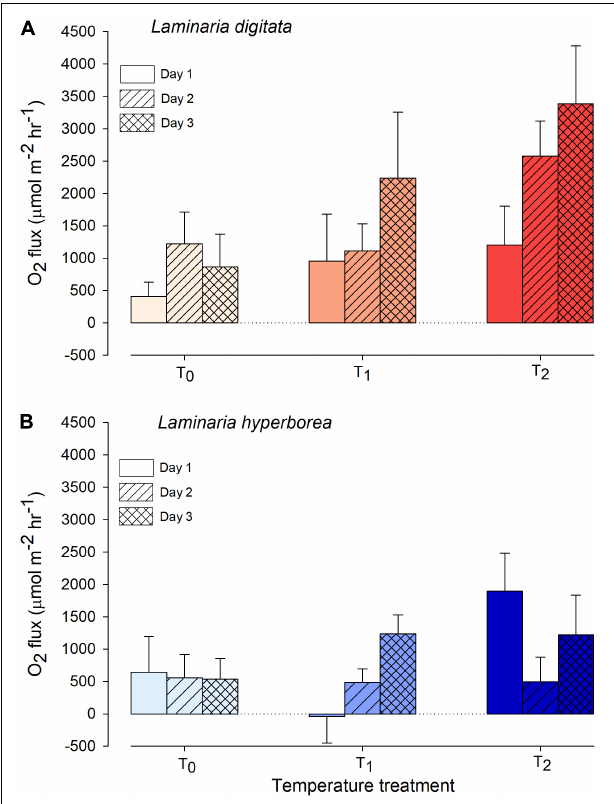
FIGURE 1 | Net daytime O 2 flux from (A) Laminaria digitata and (B) Laminaria hyperborea at each temperature treatment during a 3-day simulated heat spike. Data presented as mean ± SE ( n = 4 individual aquaria per treatment).